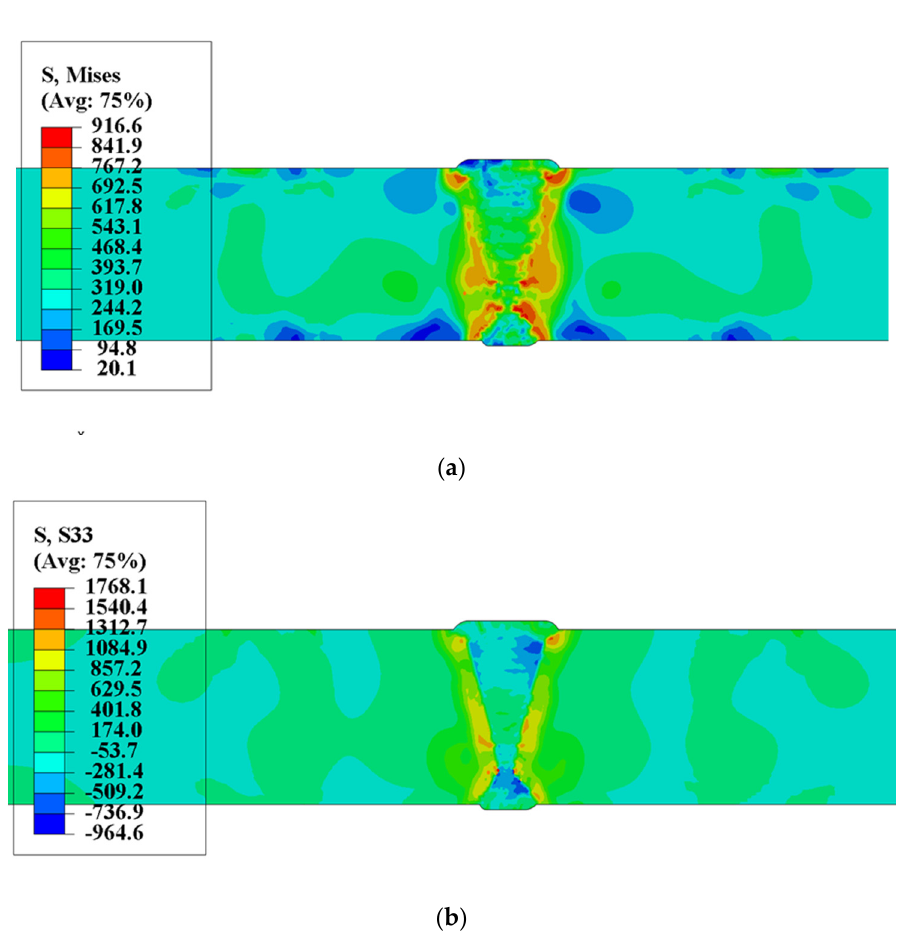
Figure 9. The result of residual stress of welded joint of heavy plate: ( a ) Equivalent Mises stress; ( b ) Longitudinal stress, (MPa).